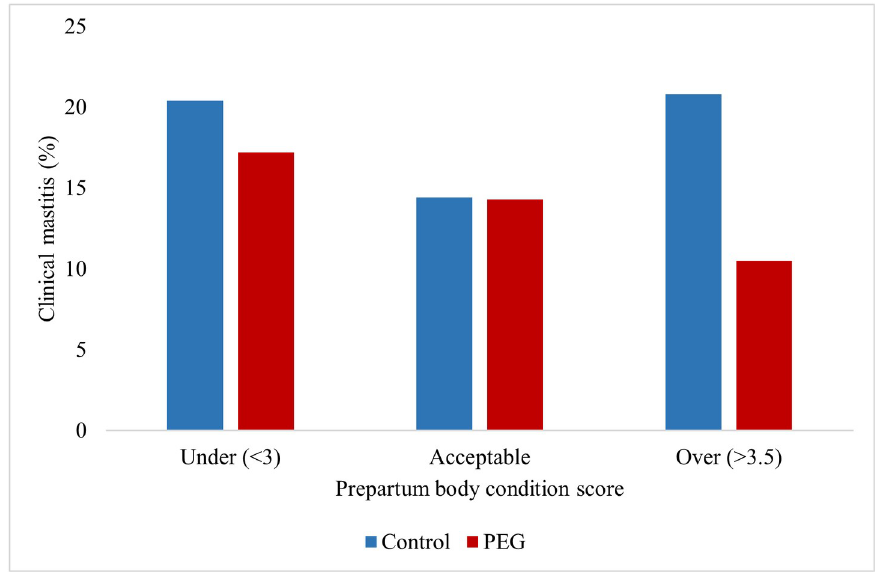
Fig 2. First case of clinical mastitis during the first 30 DIM by prepartum body condition score. Under- conditioned ( < 3; Control = 107; PEG = 99); Acceptable-conditioned (3–3.5; Control = 702; PEG = 706); Over- conditioned ( > 3.5; Control = 305; PEG = 234). In over-conditioned cows, occurrence of CM was lower in PEG treated cows ( P < 0.05).